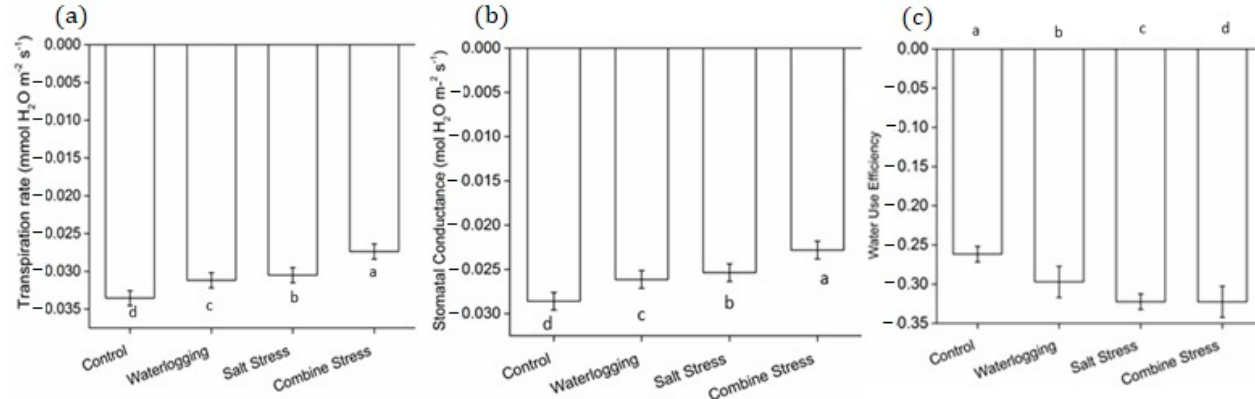
Figure 7. ( a ) Transpiration rate; ( b ) stomata conductance; and ( c ) water use efficiency of the wheat plants from 15 April 2020 to 22 April 2021 (flowering stage) grown under different abiotic stresses. Water use efficiency was measured in µ mol CO 2 m − 2 s − 1 /mmol H 2 O m − 2 s − 1 . Note: Reported values are the means and standard deviations of triplicates for each treatment (exact values are given in Table S1). Lowercase letters show the significant differences among treatments according to one-way ANOVA and DMRT, while the significance level was p ≤ 0.05.